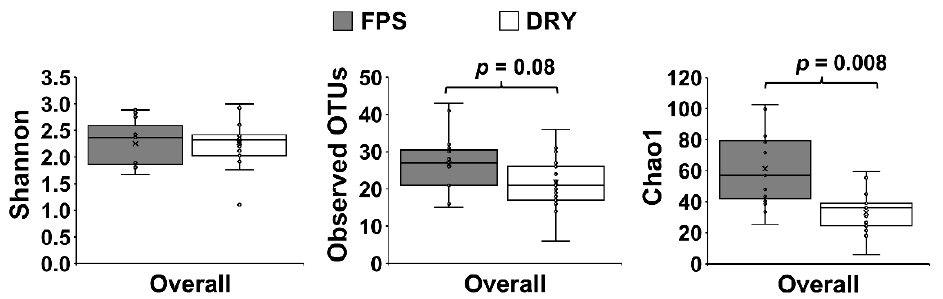
Figure 2. Skin microbiome alpha diversity of pet dogs fed fresh (FPS) versus dry (DRY) food. Ob- served OTUs, Shannon, and Chao1 indices of alpha diversity at genus level in dogs fed FPS for 30 consecutive days, followed by DRY for an additional 30 consecutive days. Values were computed using the core_diversity_analyses.py script in Quantitative Insights into Microbial Ecology. Group differences were assessed by non-parametric permutational analysis of variance with protocol and time as fixed effects, under a reduced model, 9999 permutations, and type III sum of squares. Data from different swab areas were combined for further analyses. SIMPER analysis yielded a 60.41% average dissimilarity between FPS and DRY, with 61 genera contributing to 70% of differences between FPS and DRY (Figure 3).